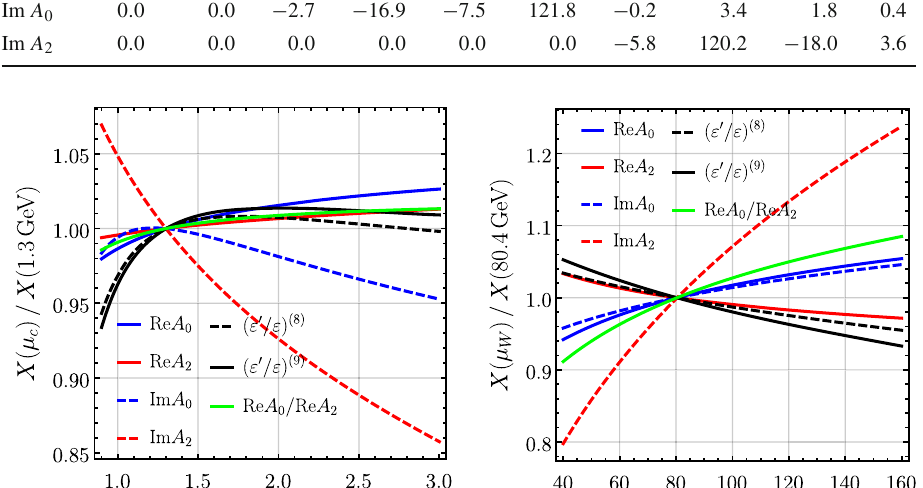
Table 3 The contribution in % of each operator to Re A 0 , 2 and Im A 0 , 2 at μ 0 , 2 .